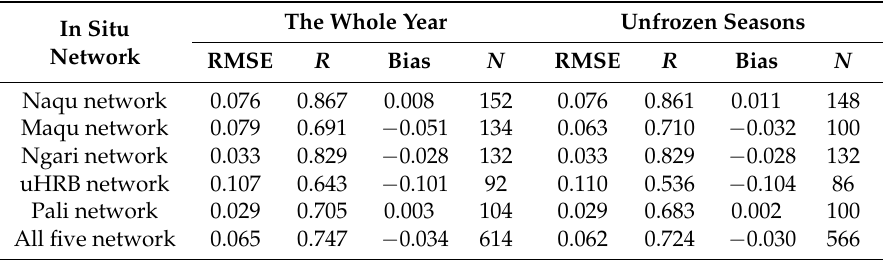
Table 3. The performance metrics for soil moisture active passive (SMAP) soil moisture (SM) data over the five networks, during 1 April 2015 to 31 December 2016. The value N indicates the number of data can be used to validate SMAP over five